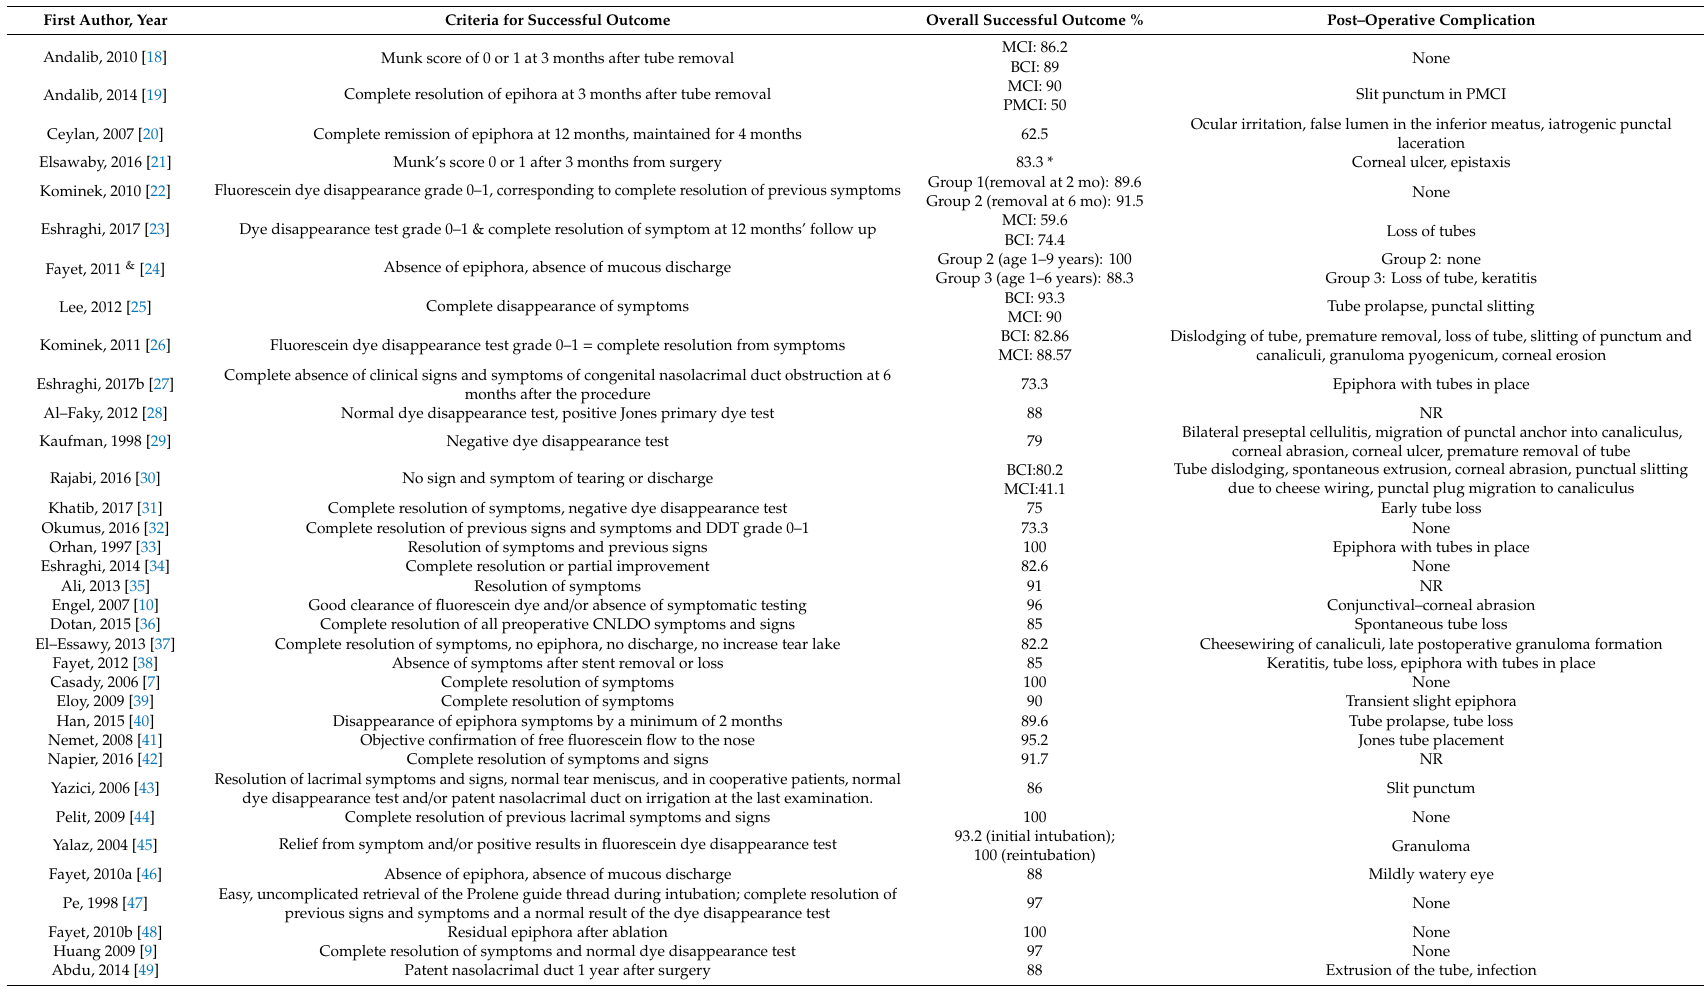
Table 2. Summary of reported